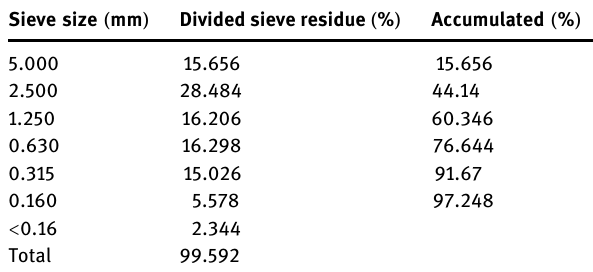
Table 2: Sieve residue percentage of Type II recycled sand Sieve